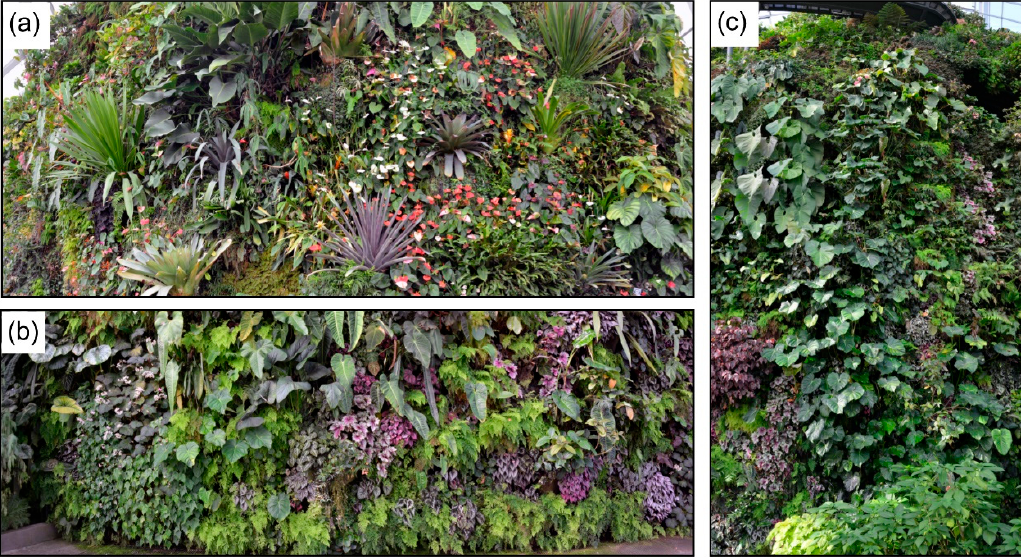
Figure 1. Photos of the different sections of the living wall. ( a ) Site A; ( b ) Site B; ( c ) Site C. Different types of plants from tropical mountain areas are distributed on the living wall.